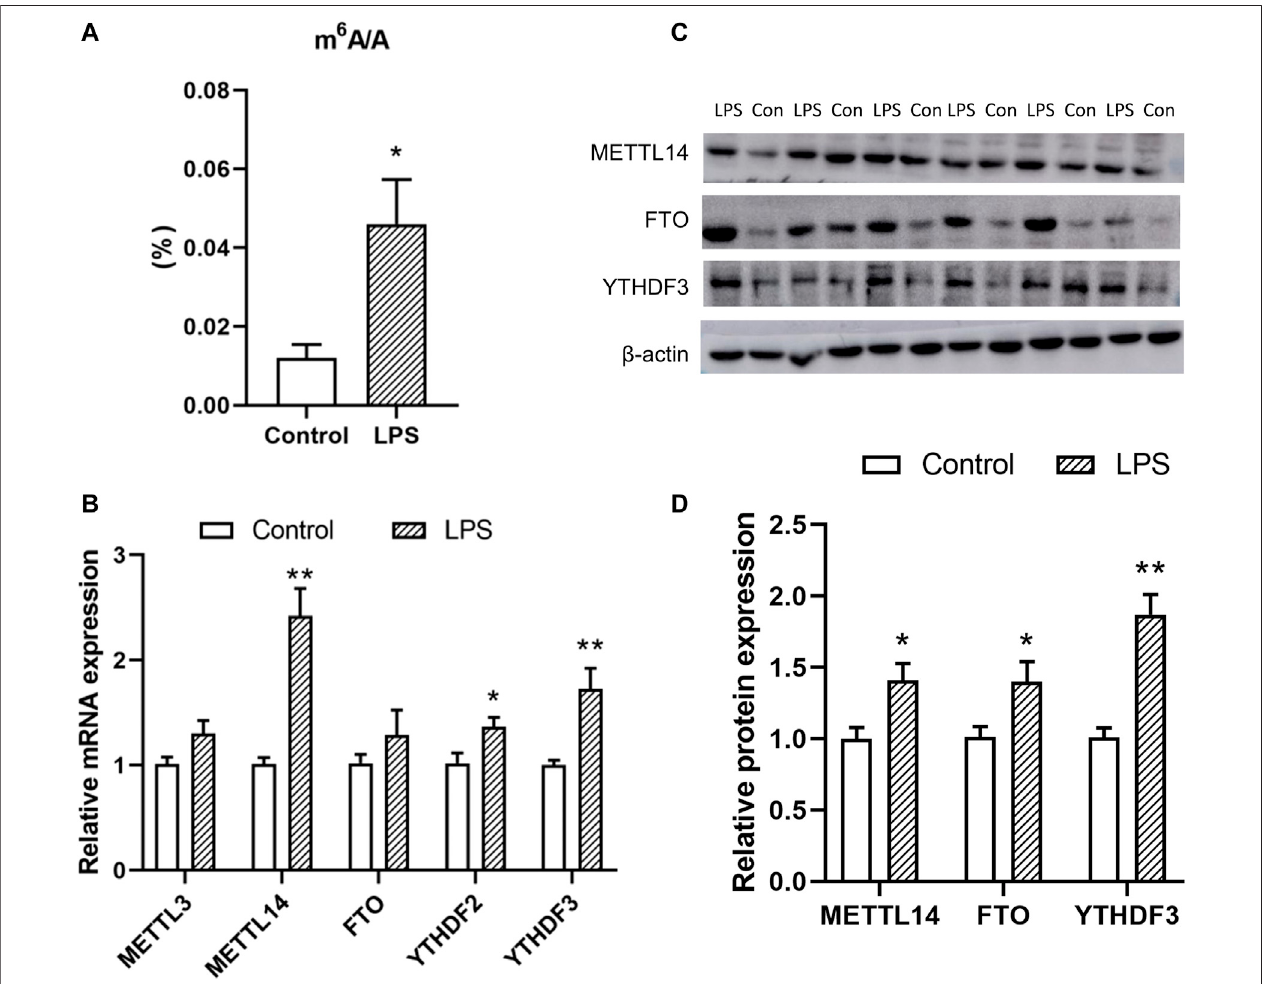
FIGURE1| EffectsofLPSonthetotalm 6 Alevel (A) andtheexpressionoftheassociatedenzymes[ (B) mRNAand (C,D) proteinlevel].Valuesaremean±SEM, n = 6/group, * p < 0.05, ** p < 0.01.